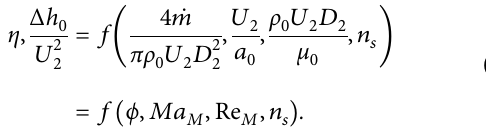
2 in the near-critical